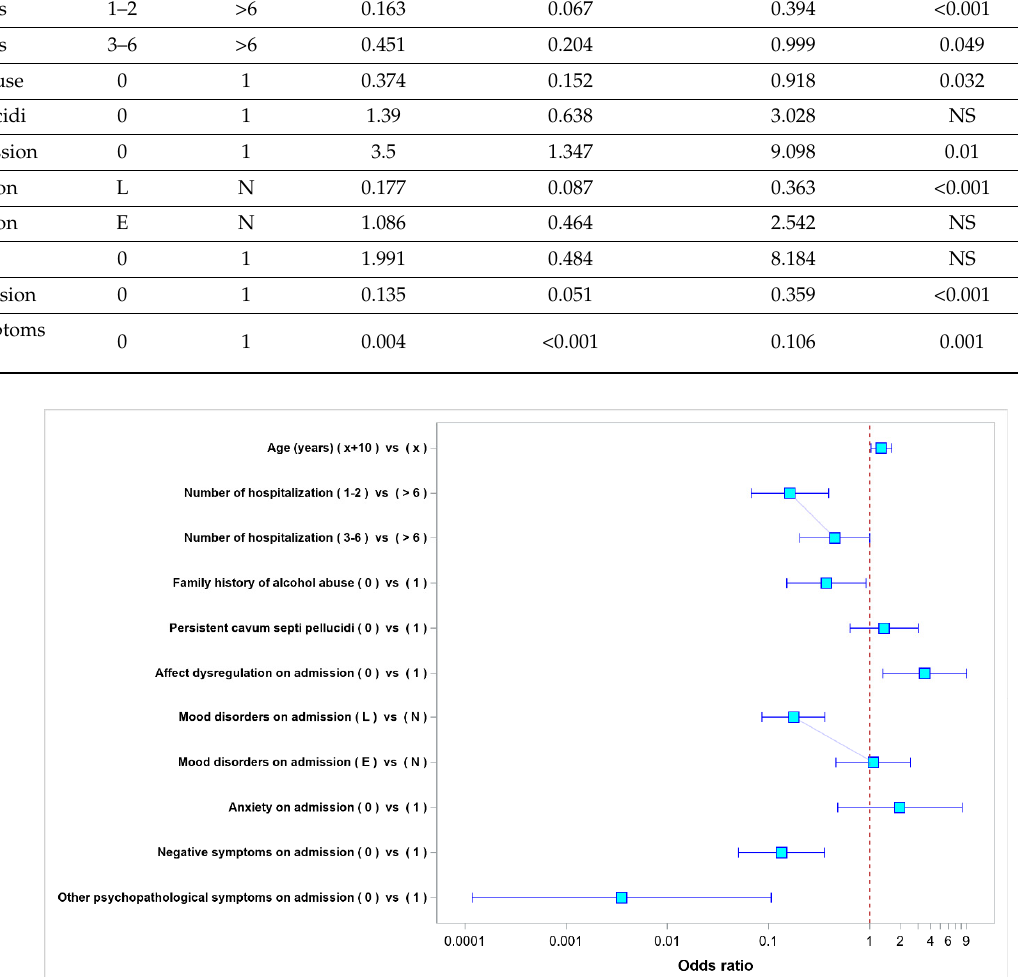
Figure 6. Odds ratio values for the parameters affecting the presence of other symptoms at hospital discharge. In summary, significant risk factors for sustained positive symptoms were older age, higher number of hospitalizations, past suicide attempts, an absent CSP, stable mood on admission; positive symptoms on admission, negative symptoms on admission, other symptoms of schizophrenia on admission, and being subjected to physical coercion dur- ing hospitalization. Significant risk factors for sustained negative symptoms were older age, past suicide attempts, an absent CSP, psychomotor agitation on admission, negative symptoms on ad- mission, and other symptoms of schizophrenia on admission. Significant risk factors for sustained other symptoms of schizophrenia were older age, a higher number of hospitalizations, a family history of alcohol dependence, an ab- sent CSP, affect dysregulation on admission, stable mood on admission, anxiety on ad- mission, negative symptoms on admission, and other symptoms of schizophrenia on ad- mission.